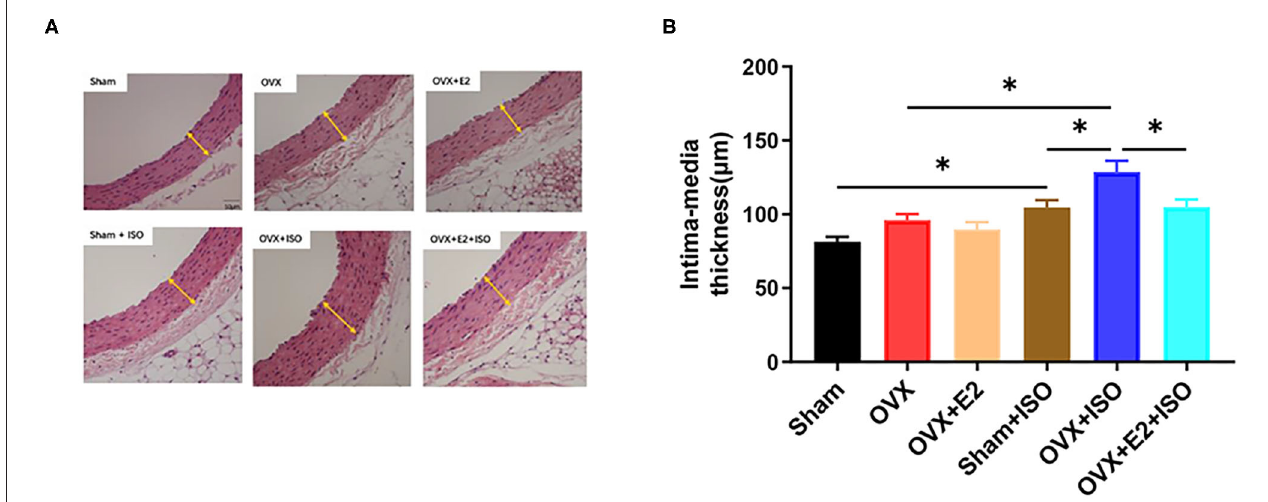
FIGURE 5 | Estrogen attenuates intima-media thickening during catecholamine stress. (A) HE staining of tissue sections. (B) Quantification of imaging results. Data are expressed as mean ± SEM. n = 6. * P < 0.05.Scale bar = 50 µ m.